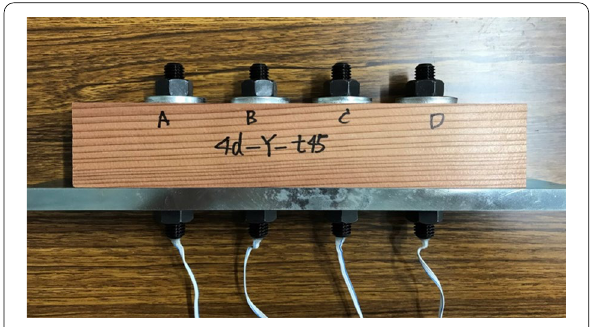
Fig. 2 Typical test piece ( S : 48 mm; T h : 45